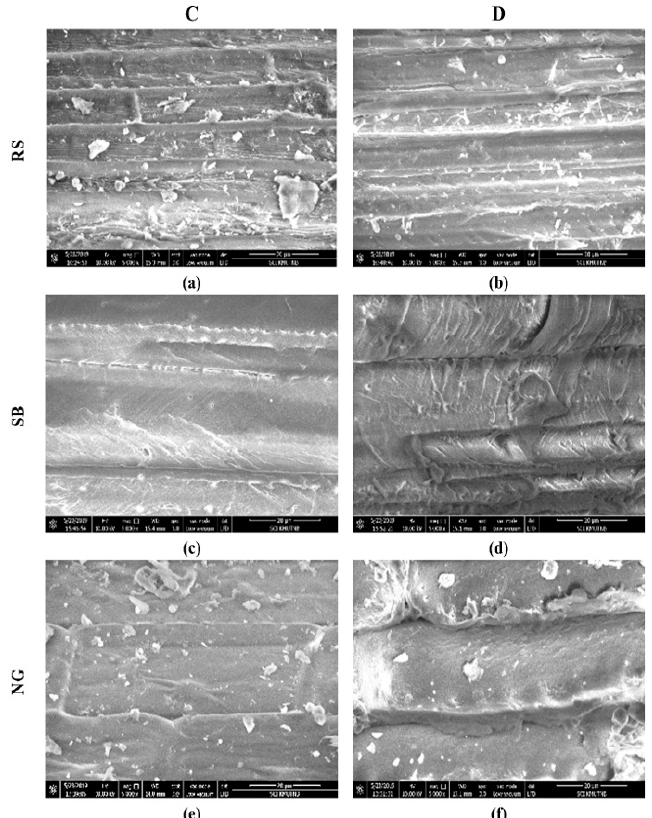
Figure 3. SEM image analysis of control (C) and dewaxed (D) samples of rice straw ( a , b ), sugarcane bagasse ( c , d ) and nepier grass ( e , f ).